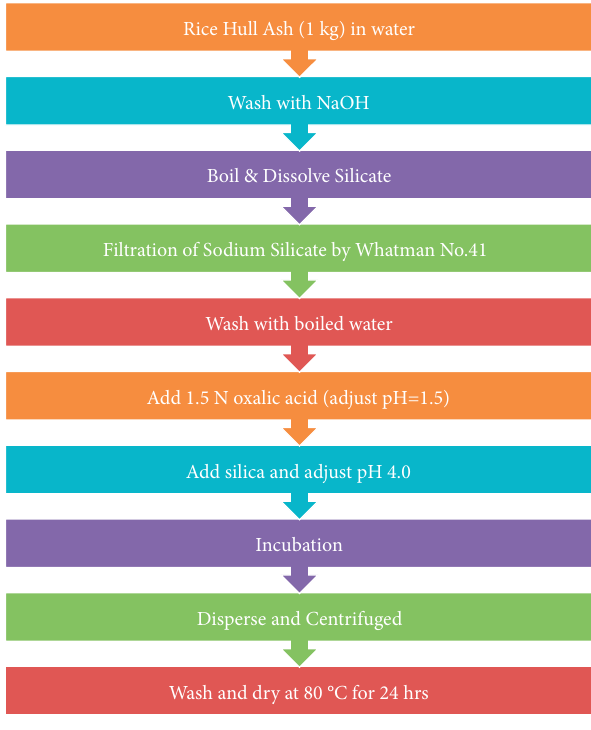
Figure 1: Flow diagram for extraction of silica from